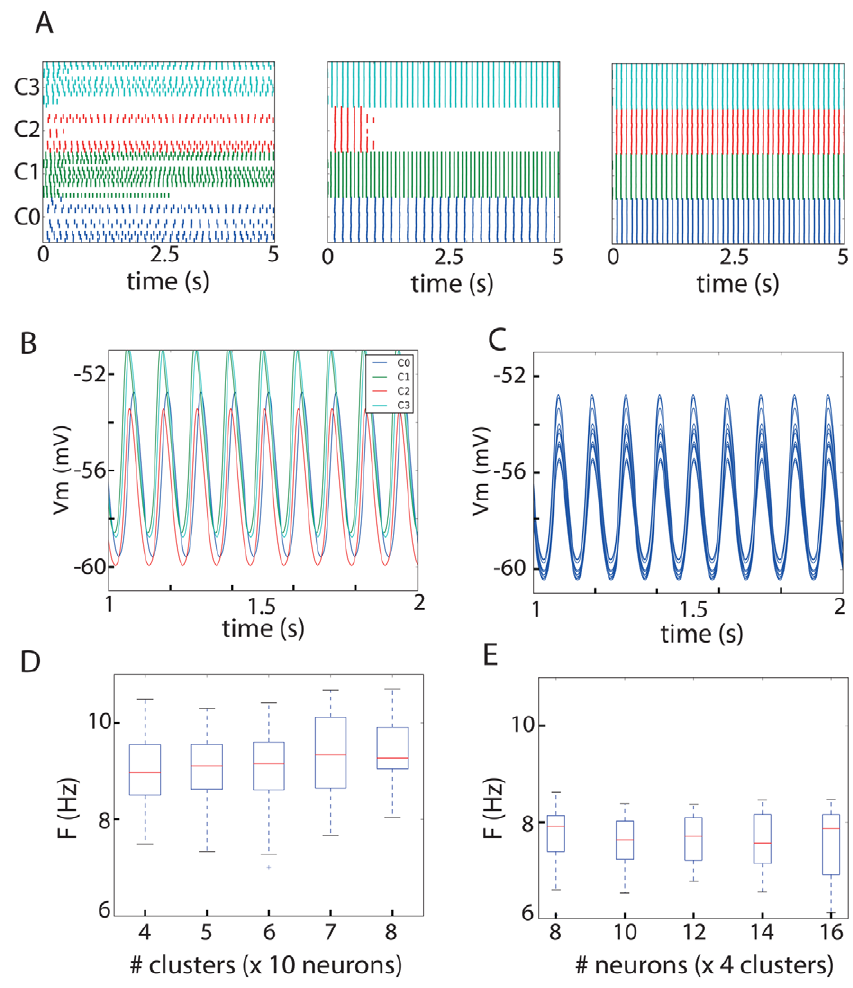
Figure 2. Stable subthreshold oscillation in a clustered network of the IO. A: Raster plot containing all neurons in the network; peaks of the oscillation are denoted by a dot. Without connections only 26 out of 48 neurons oscillate (left panel). When the intra-cluster connections are added, 3 out of 4 clusters show synchronized oscillations within the clusters (center panel). After adding the inter-cluster connections as well, the whole network reaches a synchronized oscillation of 9.2 Hz. B: Detail of the membrane potential of one neuron from each cluster indicating that the network can sustain stable subthreshold oscillations. Colors of the membrane trace and the ellipses in panel A are matching. C: Detail of the membrane potential of all neurons in one cluster (C0). D&E: Stable oscillations in the proposed network architecture are robust to changes in the number of clusters and the number of cluster per neuron. In D, networks with a varying number of clusters but a fixed cluster size (10 neurons) and a randomized connectivity scheme were tested. In E, networks with 4 clusters and a varying cluster size were tested (while the connectivity scheme was fixed as in the reference network. Therefore, the ‘‘4 clusters 6 10 neurons’’ from panel D and E are not the same). Boxplots indicate the median and the boxes extend from the lower to the upper quartile. It follows that robust synchronized oscillations can be generated by a variety of networks and that each network can achieve a range of frequencies. which the network synchronously oscillates is the frequency of the shows the voltage in four neurons: one from each cluster. At the ‘‘center of mass’’ of the connected neurons, i.e., the frequency of beginning of the simulation (t , 5 s) the network oscillates at the weighted average (in terms of the conductances) of all 6.3 Hz, and after modulating the connection strength (at t = 5 s), connected neurons in the network. The reported shift in network the network oscillates at 10.9 Hz. We changed the coupling frequency can then be interpreted as a shift of the ‘‘average strength in a biologically plausible way. Although the exact neuron’’ on the g l -g Ca plane (Figure 1A) from bottom left to top conductance change of each connection was randomized, the changes of all the connections between two clusters followed the right. The frequency change can be verified by a short-time same trend and either decreased or increased. This way, Fourier transformation (Figure 3B) and the standard Fourier heterogeneity was maintained. The changes were always limited transformation (Figure 3C). As a second step we assessed the to a sevenfold decrease/increase of the present conductance. In robustness of the mechanism that modulates the network the reference network, the modulation consisted of strengthening frequency by repeatedly changing the inter-cluster strength. For the connections from groups C3 and C4 to group C1 up to this purpose we simulated a large number of instances of the same sevenfold, while moderately decreasing their connection strength ‘‘4 cluster 6 12 neurons’’ network but with different inter-cluster with C0 by a factor of up to four. Intuitively, the frequency at connection strengths. Additionally, we also changed the coupling